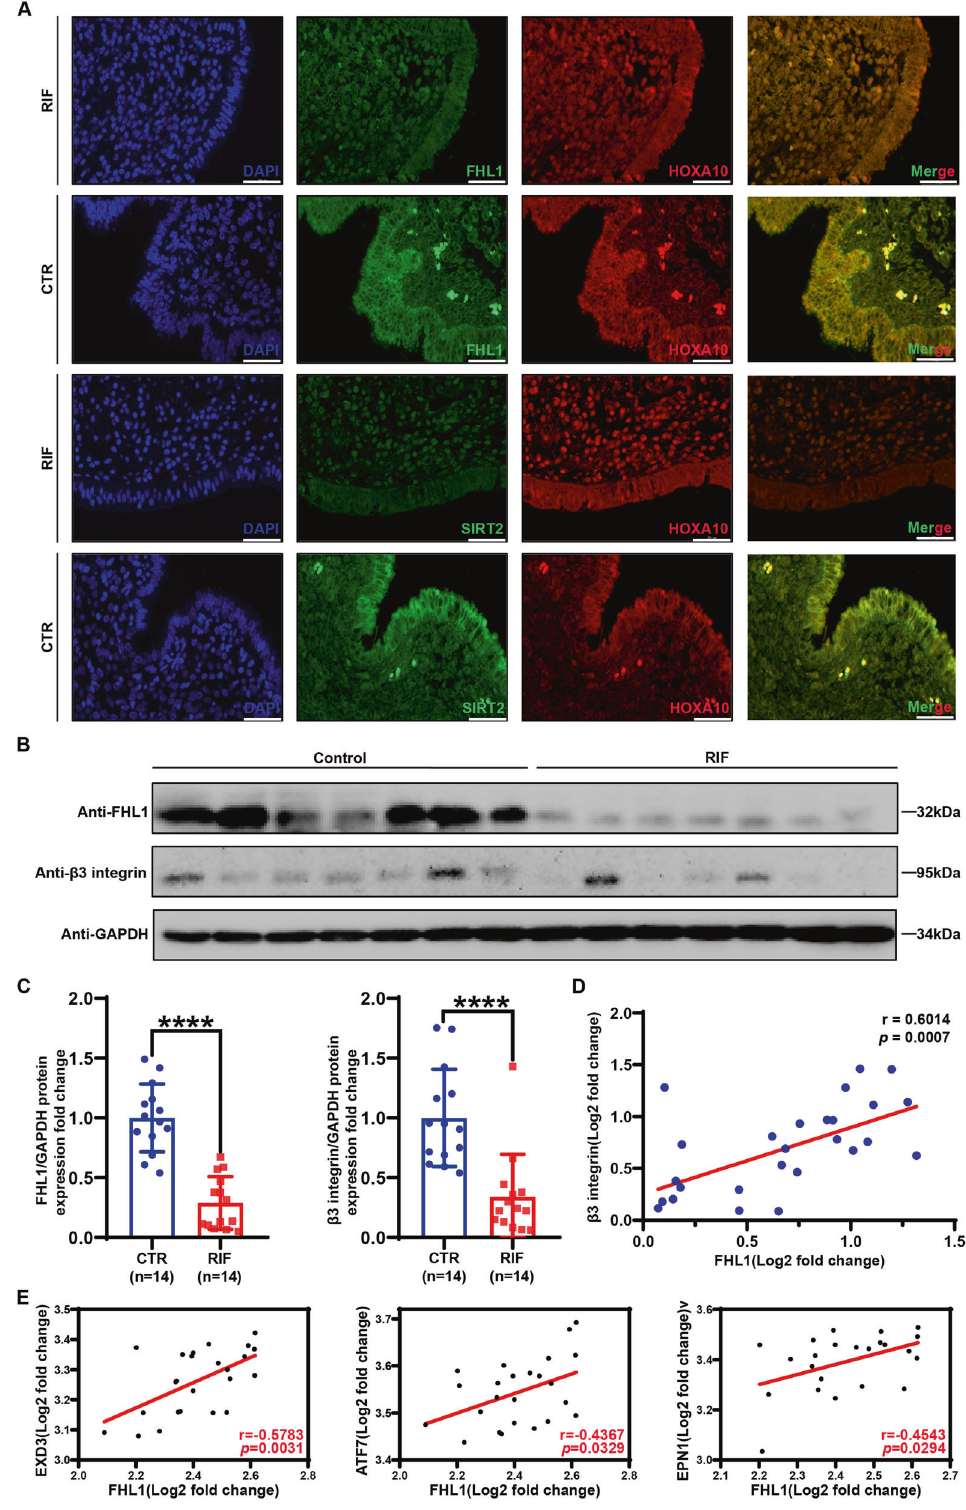
Fig. 7 FHL1 interacts with HOXA10 and its expression is signi fi cantly reduced in RIF endometrial epithelial cells. A Immunohisto fl uorescence detection of FHL1/SIRT2 (green) and HOXA10 (red) in endometrial tissue from RIF and control groups. Scale bar = 10 μ m. B , C Western blot analysis to detect FHL1 and β 3 integrin in RIF ( n = 14) and CTR (fertile woman, n = 14) human endometrial tissues. Normalization was performed with the GAPDH protein as a housekeeping protein. *** P < 0.001, by Student ’ s t test. D Correlation test for quantitative protein levels in human endometrial samples. The Pearson correlation test analyses the r and P values of protein correlations. E Correlation scores between FHL1 and mRNA levels of HOXA10 downstream target genes in RIF patients endometrial tissue in the midsecretory stage ( n = 24). The Pearson correlation test analyses the r and P values of protein correlations. The data are derived from the GSE111974 dataset.